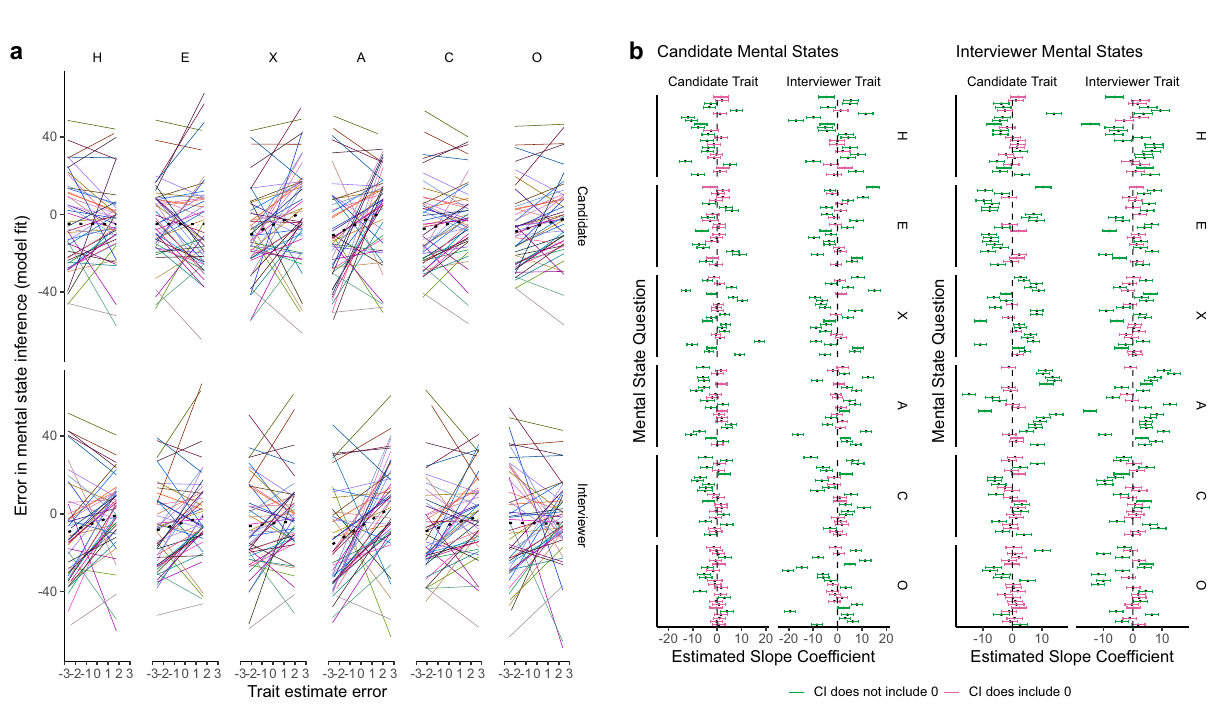
Figure 3. Plots illustrating the model estimates for the relationships between trait estimate errors and mental state inference errors in the Interview Task. (Panel a ) The specific relationships between errors in estimates of individual traits (given along the top), for specific Targets (given on the right), for different mental states (represented by different colours). The black dotted line represents the overall effect for that trait and Target. The graphs show that the relationships between specific trait errors and specific mental state errors vary such that, for some questions, a trait overestimate might be related to a mental state overestimate, but for others the relationship may be reversed. Similarly, the trait might not be relevant at all to the mental state, resulting in a flat line. (Panel b ) The estimated slopes for the effect of specific trait estimate errors (given on the right) for specific Targets (given along the top) on specific mental states (represented by separate lines). The estimated slopes for inferences about the Candidate’s mental states are given to the left, those for the Interviewer’s mental states are given to the right. Error bars are 95% confidence intervals and green lines indicate that the confidence interval does not include zero, whilst pink lines indicate that it does . This graph therefore further shows that these relationships vary between traits, i.e., each trait has a unique set of mental states which it is related to, each with its own extent and direction, and that both Targets’ minds are considered in mental state across 1000 iterations. The equivalent z-score for the residual was − 294.88, indicating that the random slope has more predictive power in our observed data than the shuffled data. No other parameter had a z-score larger than 72.10. The full parameter distributions can be seen in the Supplementary Information (section S6). Thus, although relationships between specific traits and mental states vary, relationships are systematic across par- ticipants and stimuli.